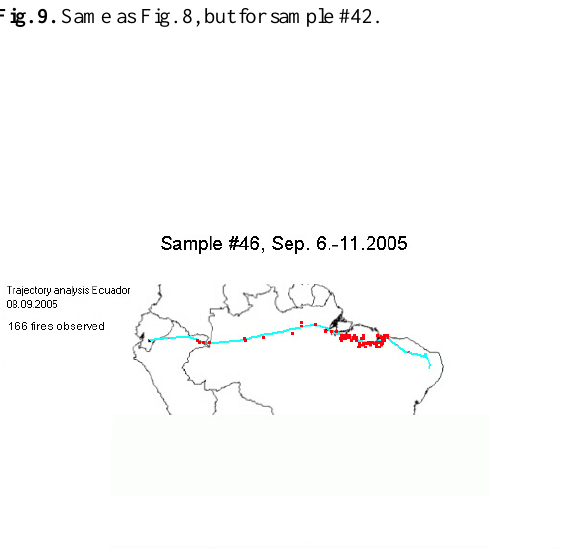
Fig. 9. Same as Fig. 8, but for sample #42.